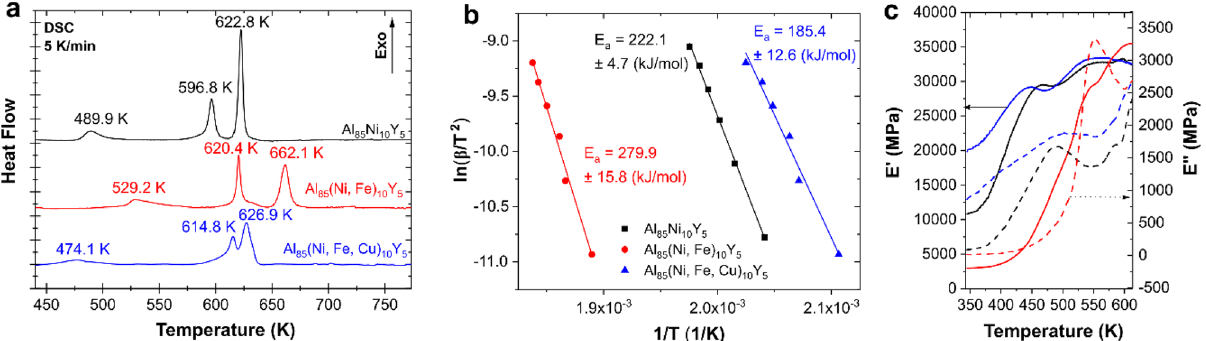
Figure 4. ( a ) Comparison of DSC curves recorded at the heating rate of 5 K/min for Al 85 TMs 10 Y 5 amorphous alloys, ( b ) Kissinger’s plots for the first observed in DSC curves peak related to the crystallization of Al phase with marked calculated activation energies, ( c ) DMA curves: storage ( E ′ ) and loss ( E ″ ) modulus as a function of temperature recorded for Al 85 TMs 10 Y 5 amorphous alloys (the colors correspond to the legend in graphics a and b